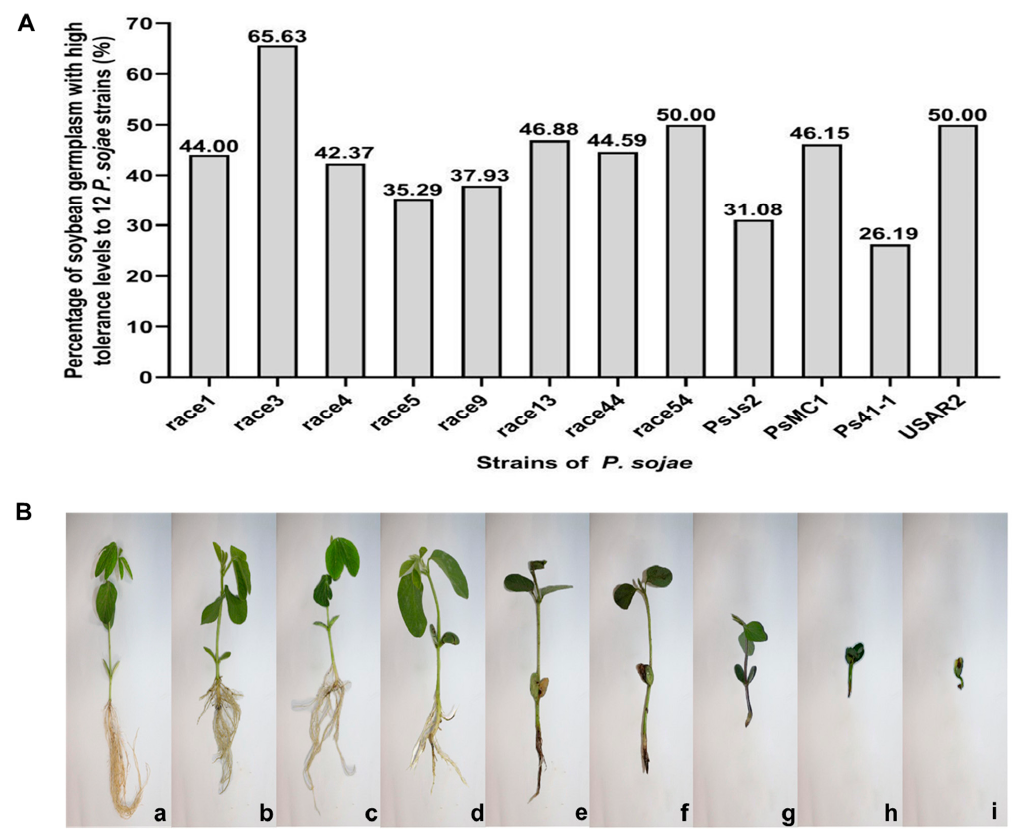
Figure 2. Partial resistance of the soybean germplasm resources. ( A ) Percentage of soybean germplasm with high tolerance levels to 12 P. sojae strains. ( B ) The reaction of roots after inoculation with P. sojae strain using inoculum layer method. a—The roots are not rotted, and the plant grows normally (denoted as 1); b—The roots of the plant are slightly rotted (denoted as 2); c—The roots of the plant are 1/3 rotted (denoted as 3); d—The roots of the plant are 2/3 rotted (denoted as 4); e—All roots are rotted, 10% of plants die (denoted as 5); f—50% of the plants died, and the plants were stunted (denoted as 6); g—75% of plants die, severe development of plants (denoted as 7); h—90% of plants die (denoted as 8); i—All plants die (denoted as 9). Table 1. List of 35 candidate soybean cultivars that showed suitable resistance and partial resistance. Number of P. sojae Cultivar (Line) Resistance